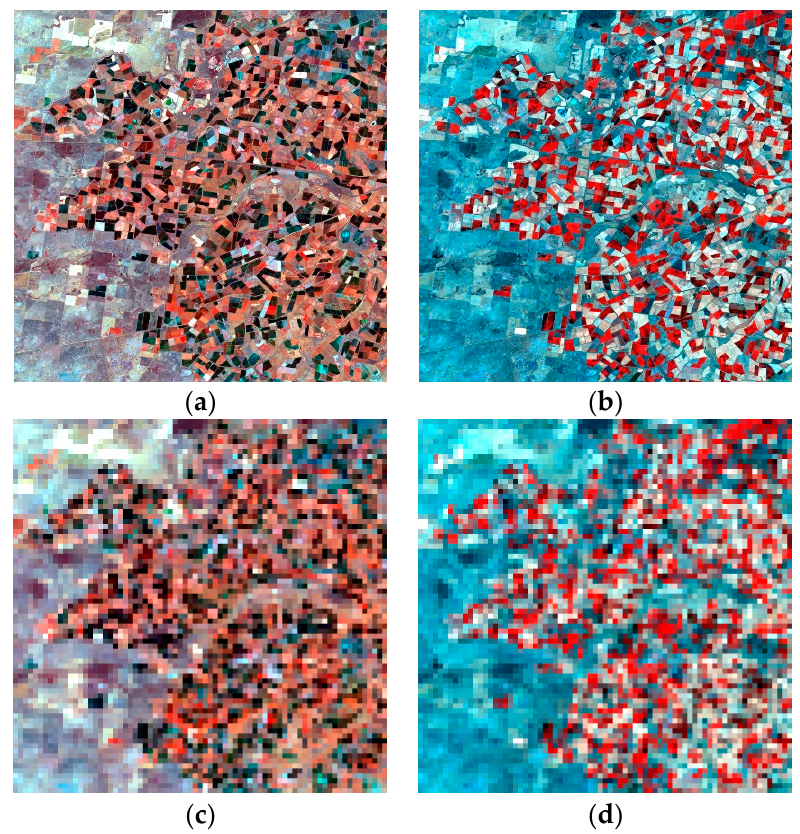
Figure 3. Dataset of Coleambally: real Landsat-7 images acquired on 25 December 2001 ( a ), and 12 January 2002 ( b ), ( c ) and ( d ) are simulated MODIS-like images with a degrading factor 16. The second set of data comes from the Lower Gwydir Catchment (“Gwydir”) located in northern New South Wales of Australia (149.2815 E, 29.0855 S). This site is representative of dramatic temporal change because of a large flooding event that occurred in mid-December 2004. The Landsat images were acquired on 26 November 2004 (T1), and 12 December 2004 (T2). Figure 4a,b show the fine images at T1 and T2, which have a size of 1600 × 1600 and a spatial resolution of 25 m. Figure 4c,d are the corresponding degraded MODIS-like images. It can be seen that many areas at T1 change to large, water-inundated areas at T2 due to the sudden flooding. Di ff erent from that in Coleambally, the large temporal change of Gwydir mainly can be attributed to the land cover type change. The input to the spatiotemporal fusion algorithm is the pair of images taken on 26 November 2004 (Figure 4a,c at T1), and the coarse image taken on 12 December 2004 (Figure 4d at T2). The output is the predicted fine image at T2 based on the three available images. Figure 4b is the reference image for the predicted image at